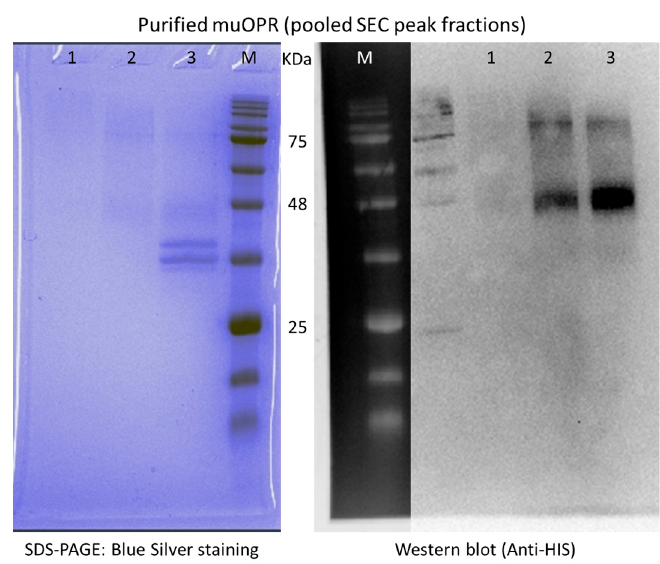
Figure 9. SDS-PAGE (blue silver staining) and Western blot (anti-HIS tag staining) of the eluted fractions of mu opioid-receptor obtained from HiLoad 16/600 superdex 200 pg column demonstrating the presence of the receptor (see Materials and Methods). Lane M is BlueElf prestained protein marker. The muOPR sample used for binding measurements is from Lane 2. Int. J. Mol. Sci. 2018 , 19 , 272